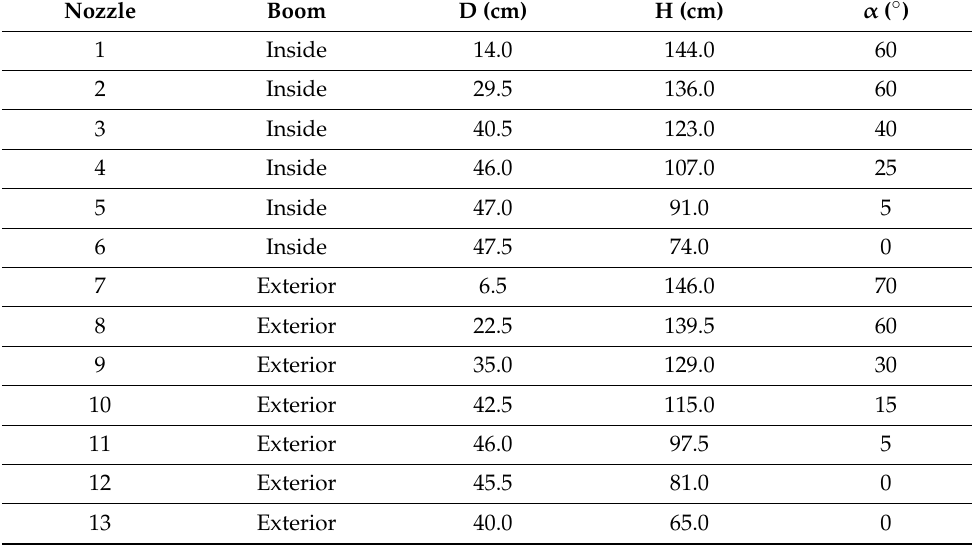
Figure 2. Schematic of the angles α and β that defined the orientation of the nozzles in both sprayers, where X: horizontal axis, parallel to the main air flow direction, and perpendicular to the longitudinal sprayer axis; Y: horizontal axis, perpendicular to the main air flow direction, and parallel to the longitudinal sprayer axis; and Z: vertical axis. Table 2. Position and orientation of the nozzles in the air-assisted sprayer with a circular outlet deflector (C sprayer). All the nozzles were considered for the sprayer C2, while nozzles between numbers 7–13 were considered for the sprayer C1. D: distance of the nozzle from the vertical central axis of the fan. H: height of the nozzle with respect to the ground. α : angle formed by the projection of the nozzle in the XZ plane ( β was 90 ◦ in all